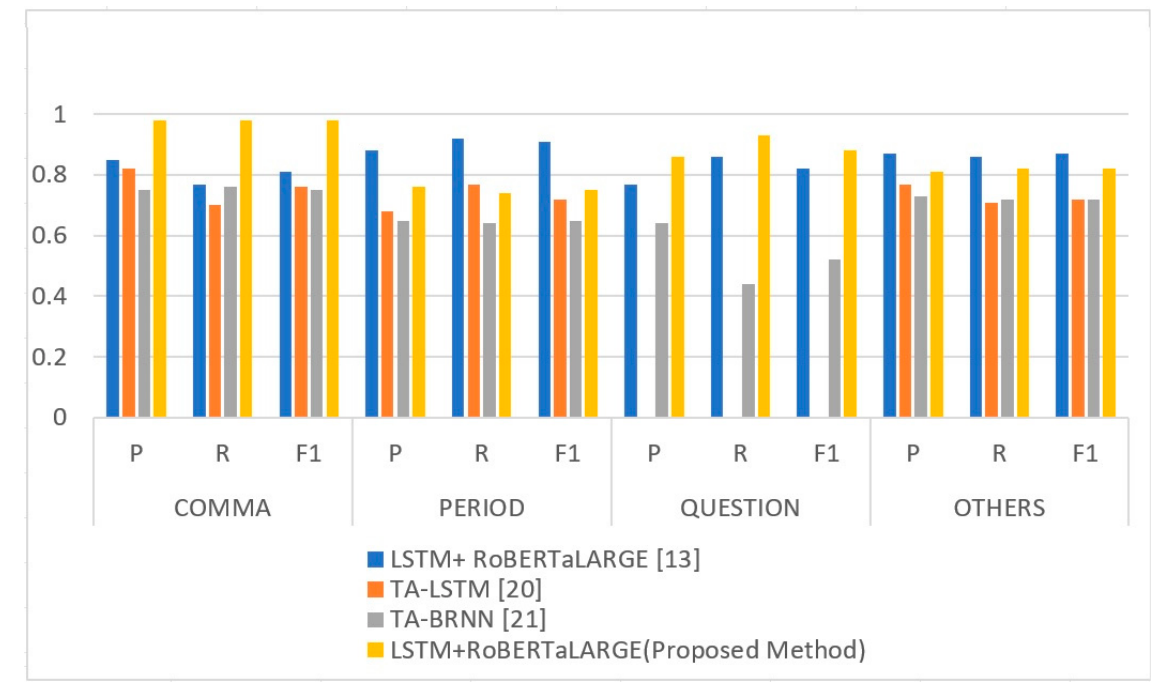
Figure 4. Proposed model comparison with existing models.